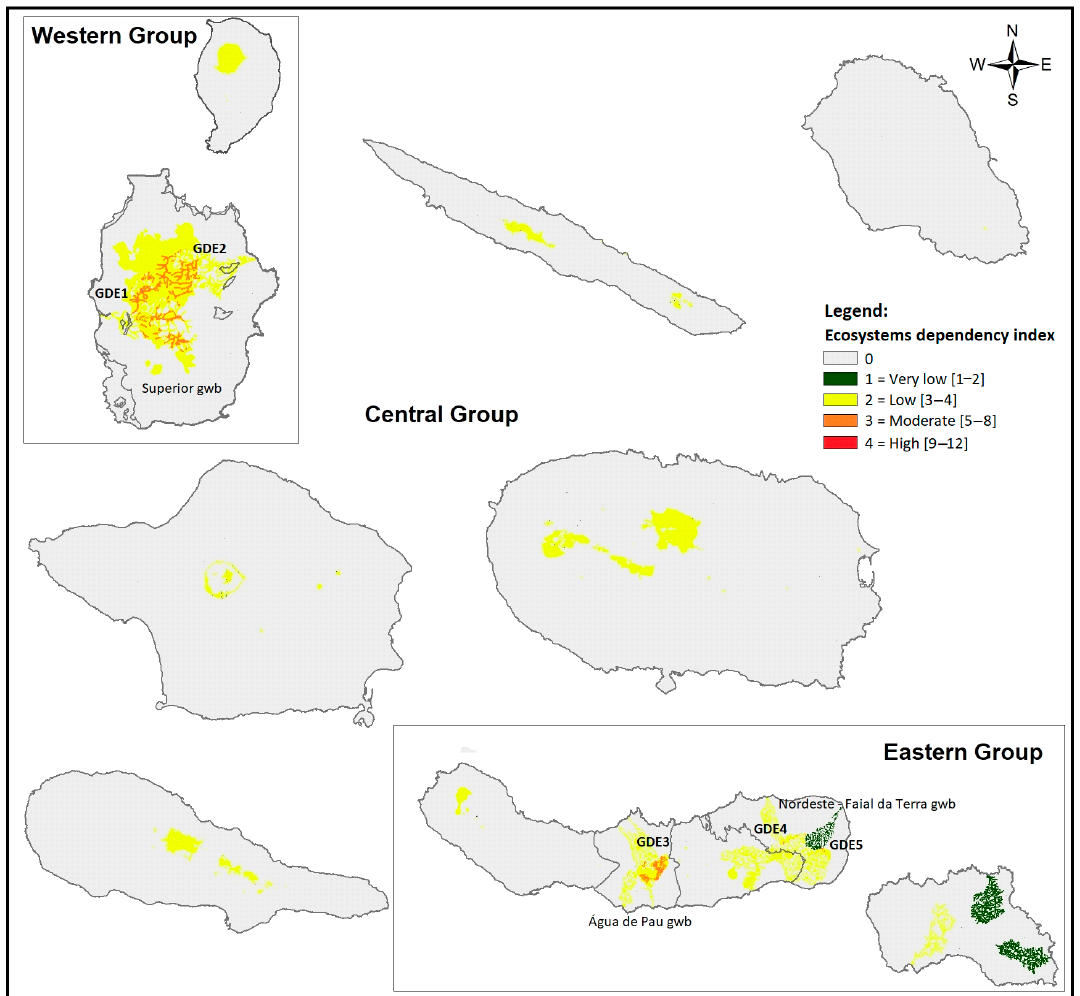
Figure 5. Mapping of the ecosystem dependence index in the Azores River Basin District.